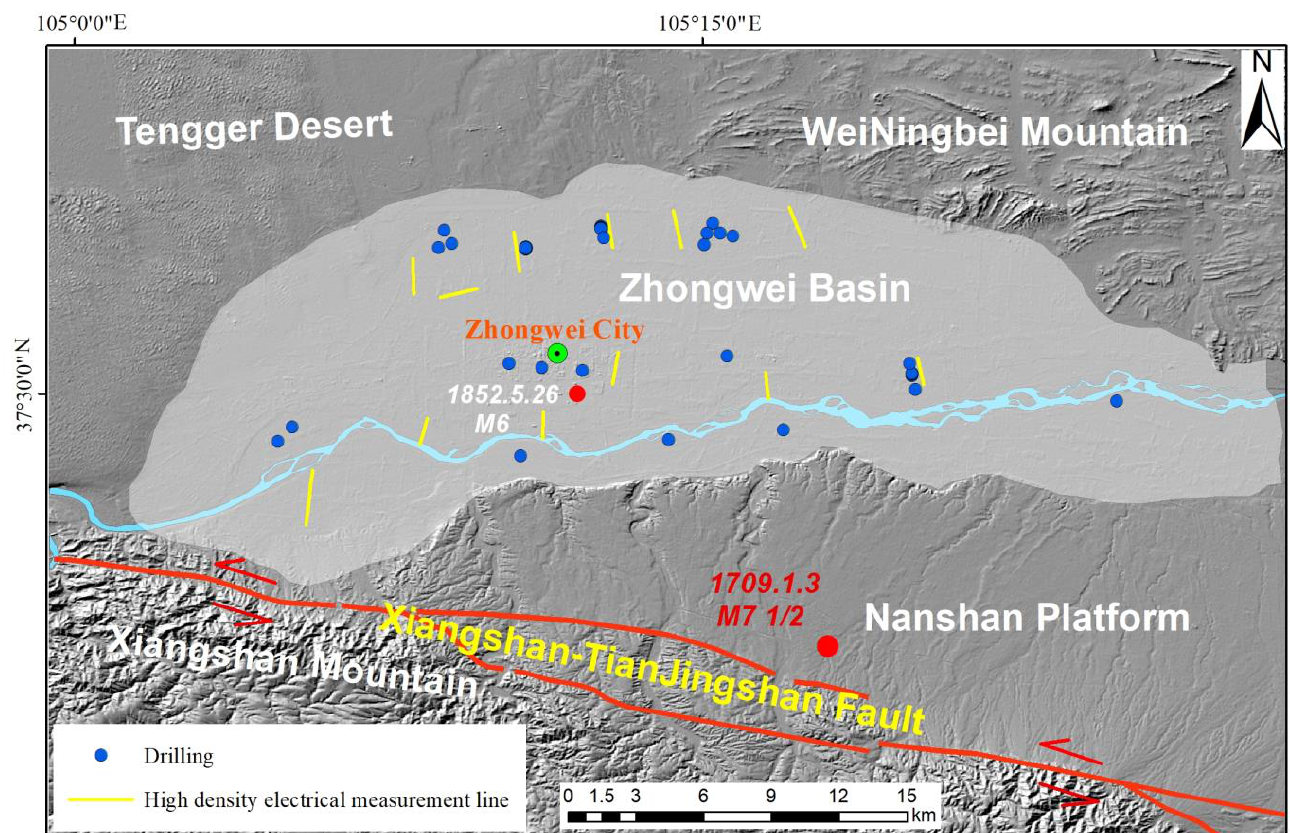
Figure 1. Seismic and tectonic background map of Zhongwei Basin.